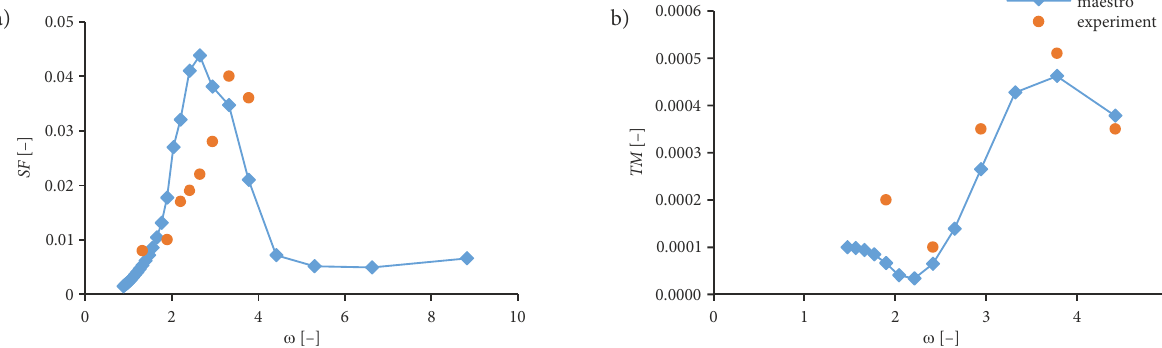
Figure 5. RAOs of vertical shear forces SF (a) and longitudinal torsion moments TM (b) in bow quartering seas ( b = 150) at F n =